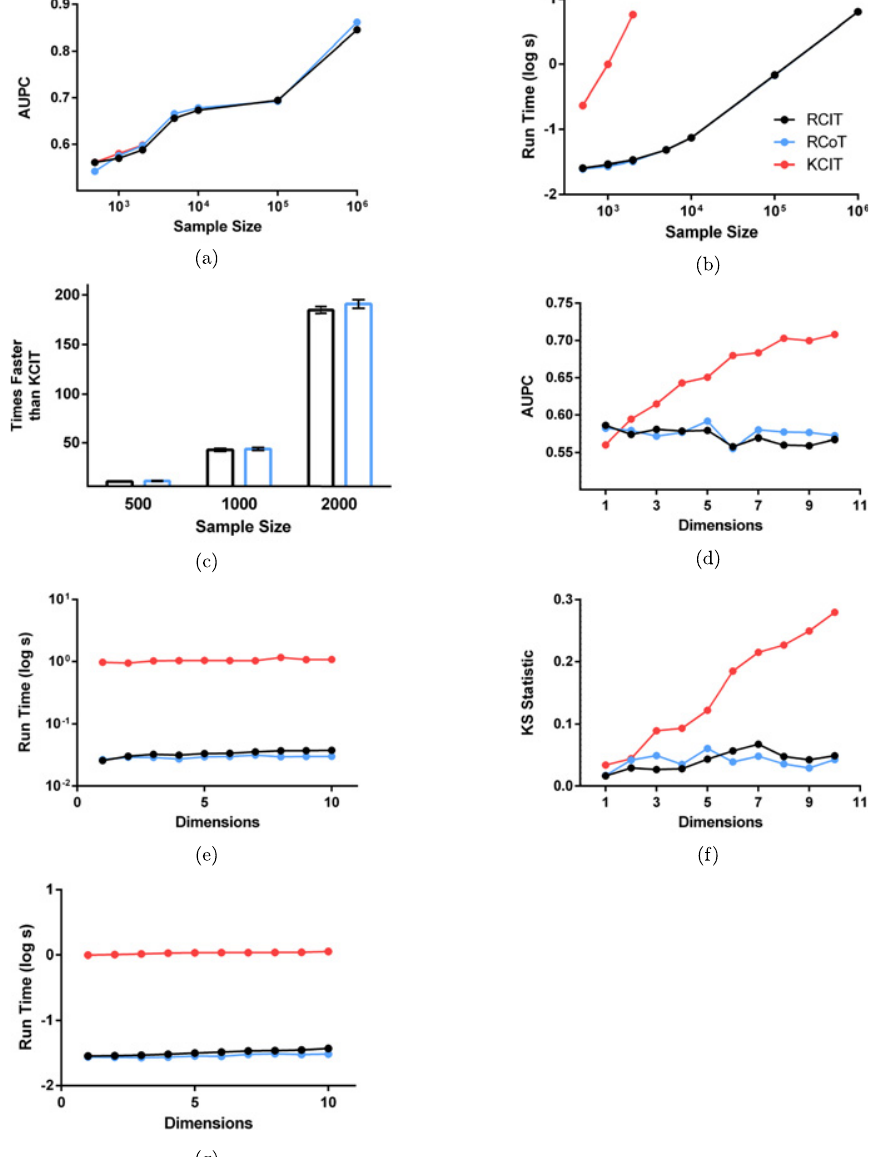
Figure 2: Experimental results with RCIT, RCoT and KCIT as a function of sample size and conditioning set size when conditional dependence holds. (a) All tests have comparable AUPC values as a function of sample size with a conditioning set size of one. (b–c) Both RCIT and RCoT again complete much faster than KCIT. (d) KCIT’s AUPC value unexpectedly increases with the dimen- sionality of the conditioning set. Associated run times for (d) in (e). (f) The cause of KCIT’s AUPC increase lies in a badly cali- brated null distribution; here we see that only KCIT’s KS statistic value increases under the null. Associated run times for (f) in